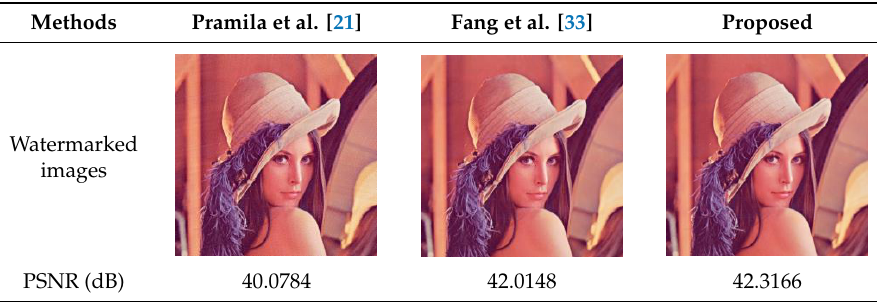
Table 3. Images generated by di ff erent